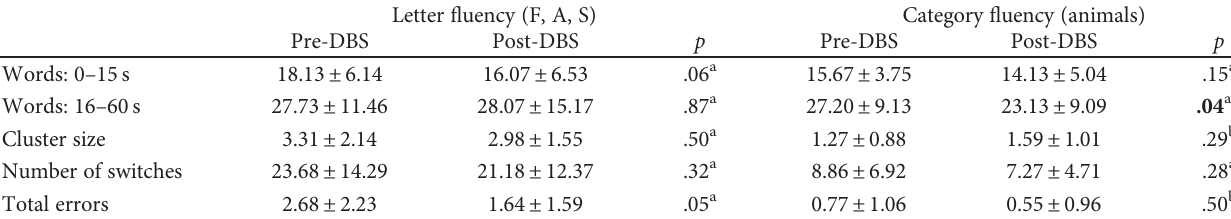
Table 6: Letter and category fl uency characteristics pre- and post-DBS.